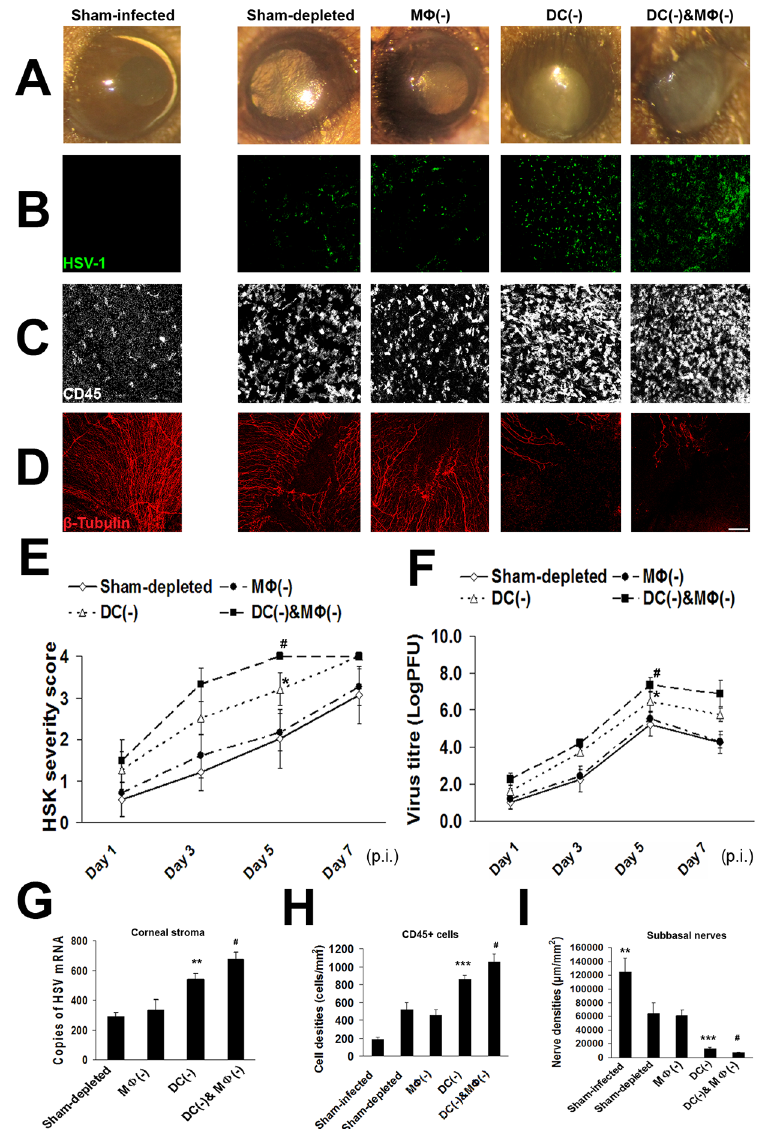
Fig 3. Upon depletion of corneal conventional dendritic cells, virus titers and the local corneal damages are significantly increased in primary herpes simplex keratitis. Infected corneas (n = 5/time point) were collected and virus titers, HSV mRNA levels measurement, or immunohistochemistry studies were performed. cDC and M Φ depletion were compared to sham-depleted infected mice after subconjunctival injections of DT and CL into CD11c-GFP-DTR or C57BL/6 WT mice, as well as to sham- infected mice without active viral inoculation (culture medium alone). Keratitis severity was graded (n = 5/time point). A: Representative corneal photos of primary acute herpes simplex keratitis severity of the mice in different groups are shown. B: Representative micrographs of viral invasion into the corneal stroma of the mice in different groups are shown. C: Representative micrographs of inflammatory cells (CD45 + ) infiltrating into the corneas of the mice in different groups are shown. D: Representative micrographs of nerve destructions of the mice in different groups are shown. E: The keratitis severity after HSV inoculation in cDC depleted (cDC(-)) mice was significantly increased as compared sham-depleted and M Φ -depleted (M Φ (-)) mice. The keratitis severity with cDC/M Φ double-depletion (cDC(-)&M Φ (-)) was further increased compared to cDC(-) mice. F, G: The viral titer levels (day 5 p.i.) of corneas and HSV-1 mRNA of the corneal stroma were significantly increased in cDC(-) corneas compared to sham controls or M Φ depletion. Double-depletion of cDCs and M Φ s showed significantly HSV levels compared to cDC depletion alone. H: Increased inflammatory (CD45+) cells infiltrated corneas with cDC depletion (day 5 p.i.) compared to controls. cDC and M Φ double depletion resulted in increased CD45+ cells compared to cDC depletion alone. I: Corneal